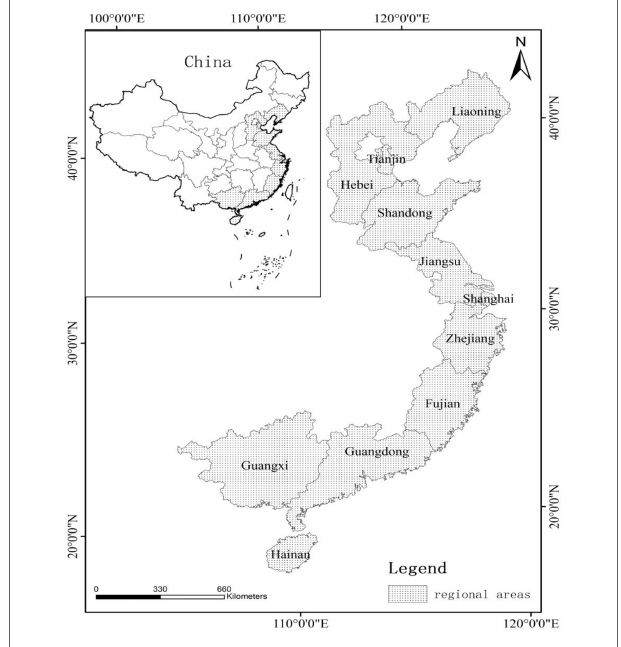
FIGURE 1 | Location of each of the regional areas considered in this